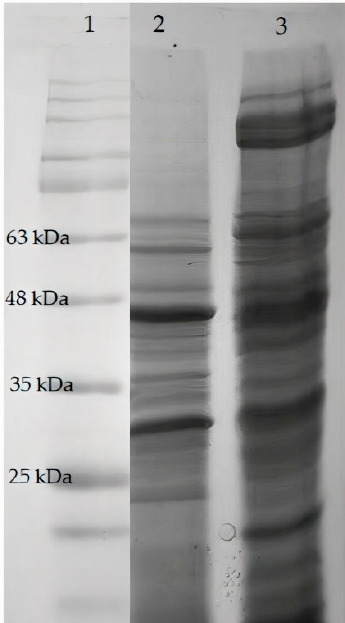
Figure 3. Electrophoretic profile of enzymatic extract produced. (1) Low-molecular-weight marker; enzymatic extract produced using (2) standard medium and (3) optimized medium.